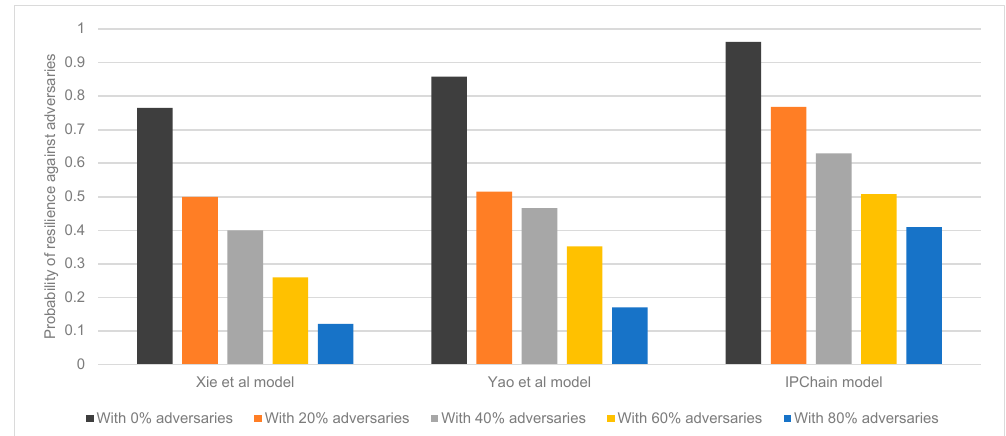
Figure 7. Evaluation of the models’ resiliency against varied percentages of adversaries.